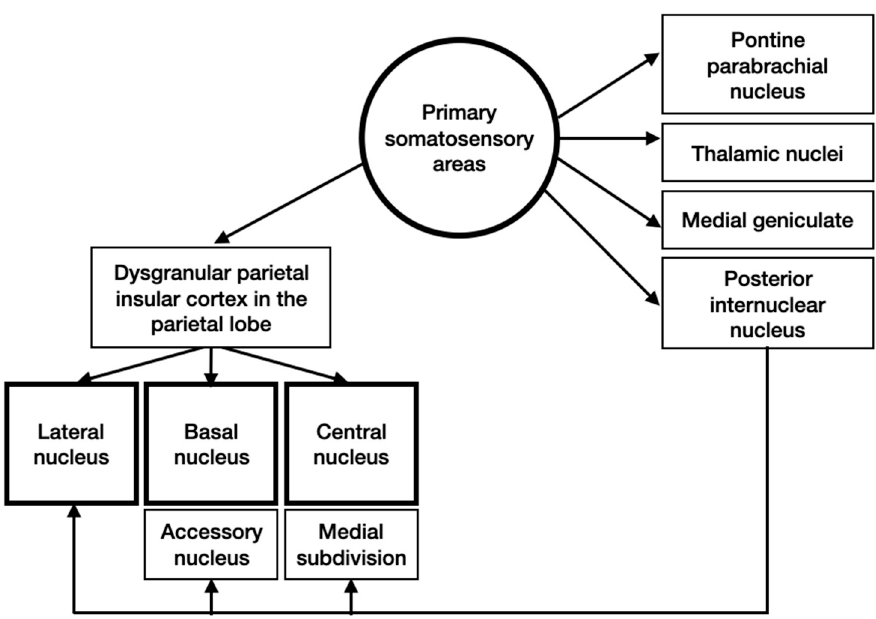
Figure 3. Schematic representation of somatosensory inputs to the amygdala.